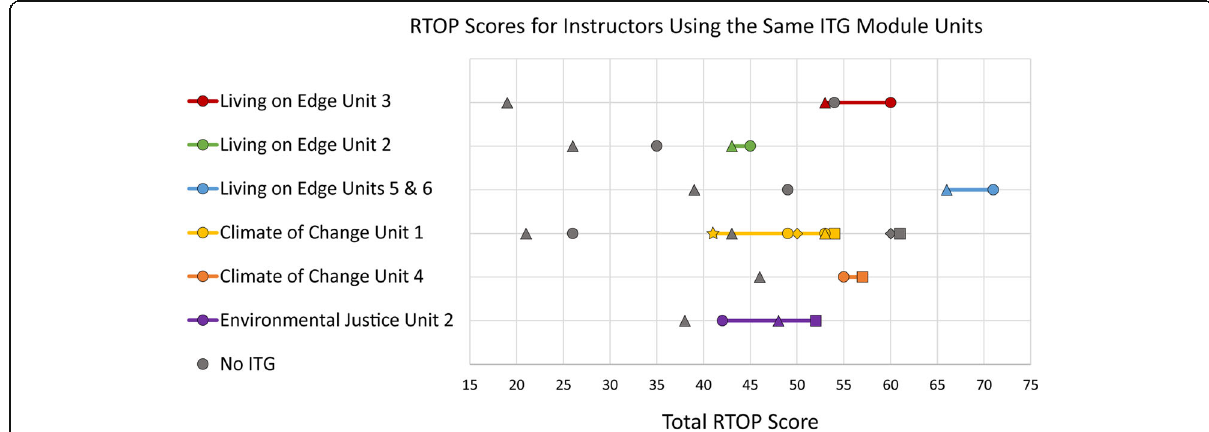
Fig. 9 Comparison of RTOP scores for individual instructors teaching with the same ITG materials. Colored lines represent the range of RTOP scores for instructors teaching with the same ITG materials; colored symbols indicate the RTOP scores for individual instructors. Grey symbols represent RTOP scores for the same instructors when not teaching with ITG. Matching symbol shapes indicate the same instructor within each ITG unit grouping